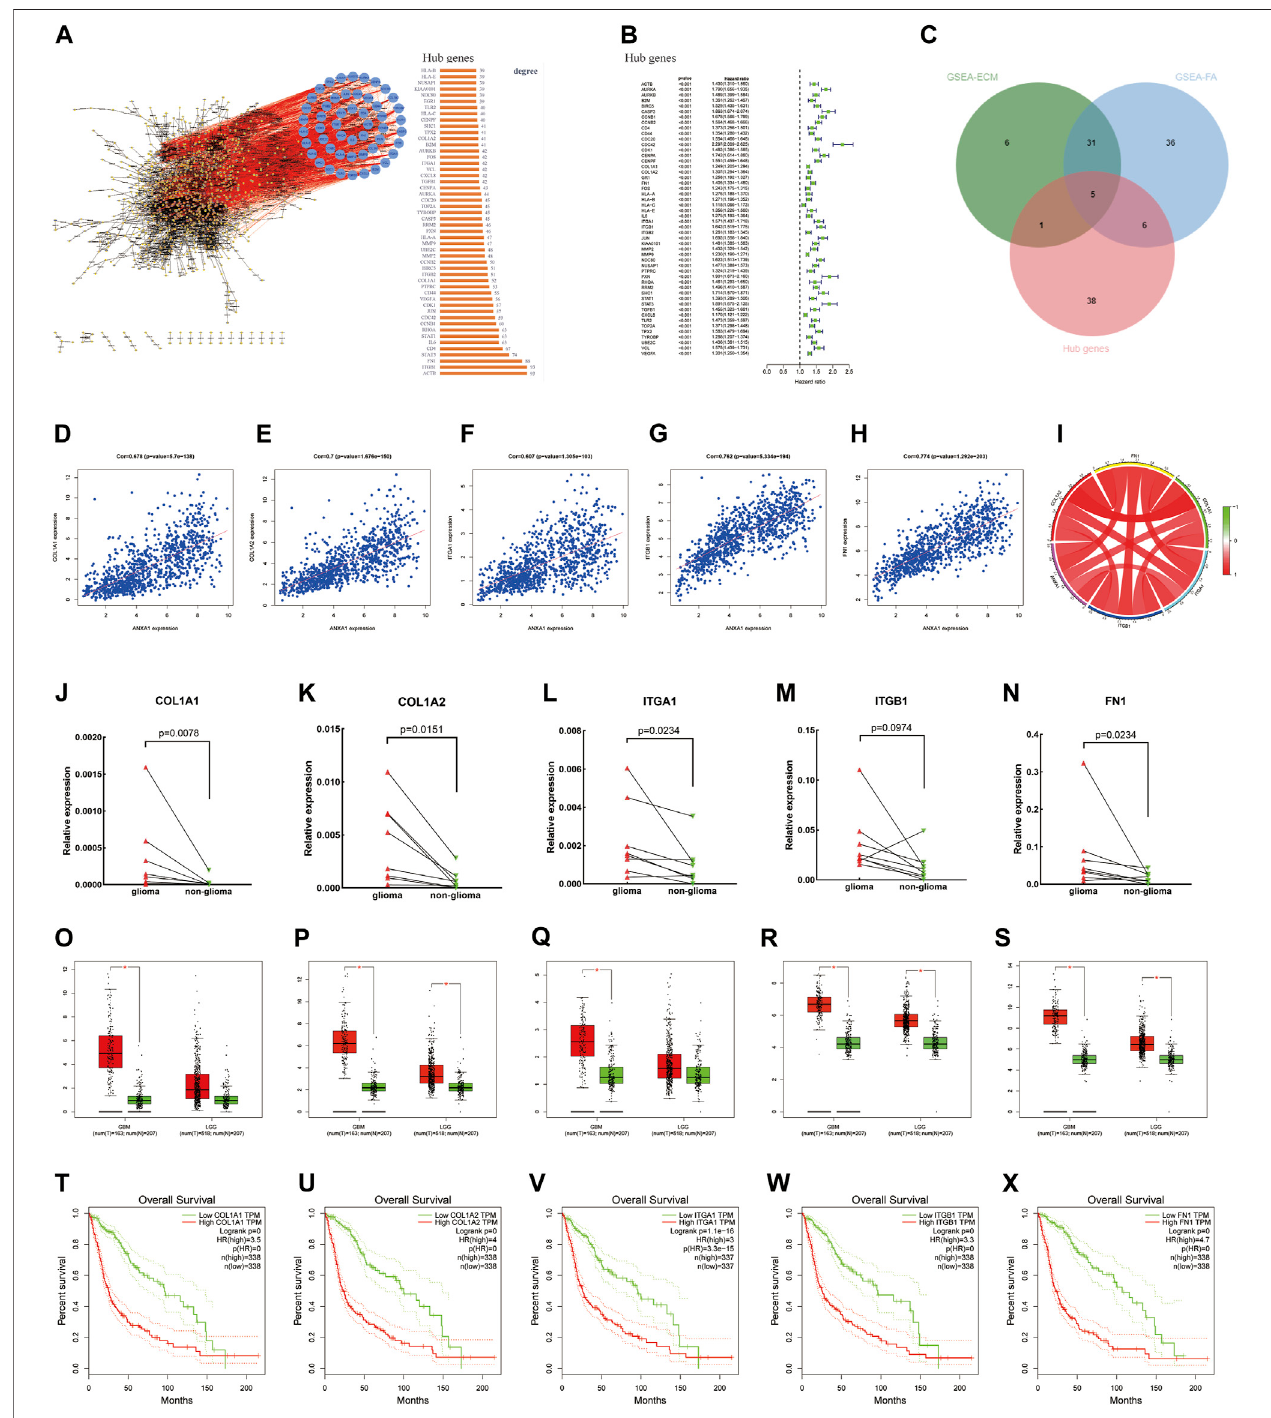
FIGURE 6 | Screening of core genes, gene correlation analysis, and prognostic analysis. (A) PPI was constructed by the STRING online website and Cytoscape visualization software, and the top 50 Hub proteins with degree values were screened. (B) Univariate regression analysis of the top 50 Hub genes. (C) Intersection betweenECM – receptorinteractionandfocaladhesionpathway genesand50Hubgenesanddisplayed bytheVenndiagram. (D – I) Genecorrelationcirclediagramand scatter diagram. (J – N) Relative expression levelsofthe fi vecoregenesweredetected byqPCR. (O – S) Expressionlevelofcoregenesinglioma andnormaltissues according to the analysis of the GEPIA online website. (T – X) High expression level of the core genes has poor prognosis in gliomas.